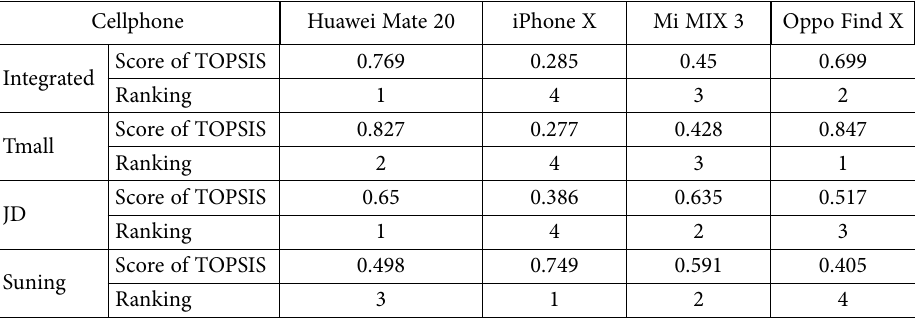
Table 14. The scores and rankings of each mobile phone on both the single platform and integrated decision